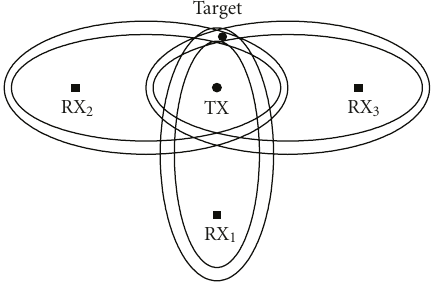
Figure 7: Localization with three receivers and imperfect TOA